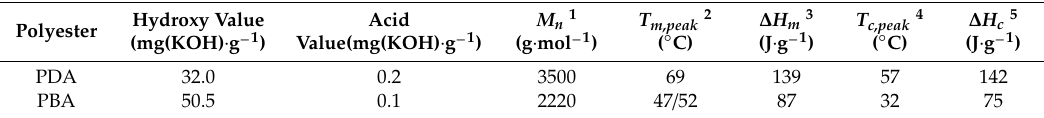
Table 1. Results of functional group analysis after titration and thermal properties of polyester diols as determined from DSC